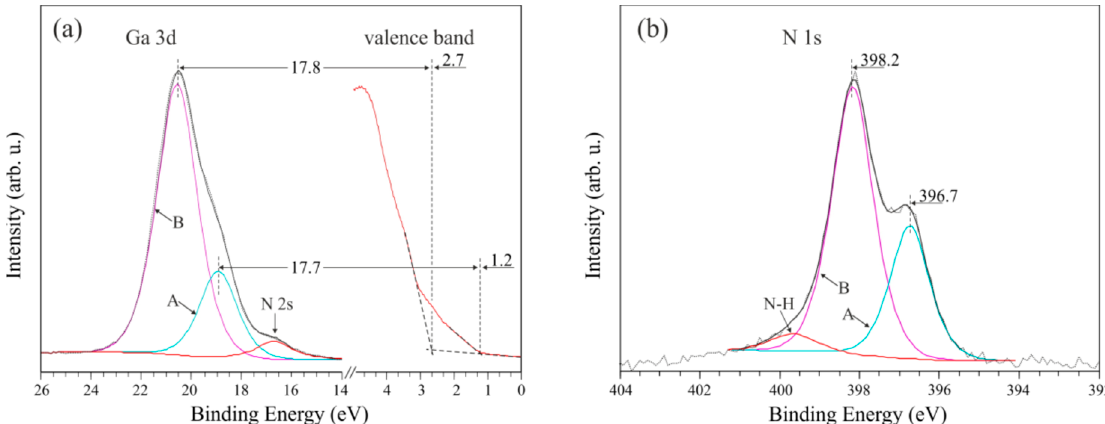
Figure 11. XPS measurement of a p ‐ GaN(0001) sample. ( a ) Ga ‐ 3d electronic state and valence band; ( b ) N ‐ 1s core level. Reprinted with permission from [74]. Copyright 2018 Elsevier.